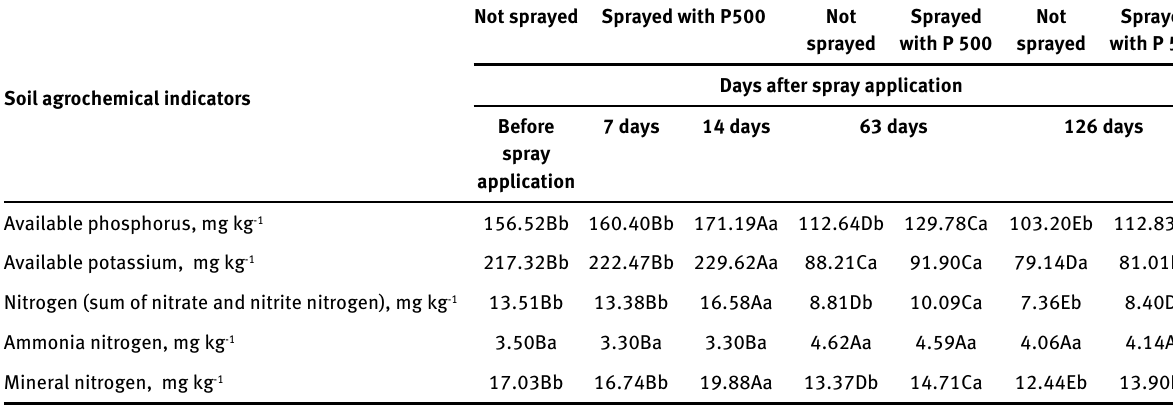
Table 1: The effect of BD preparation 500 on soil agrochemical indicators